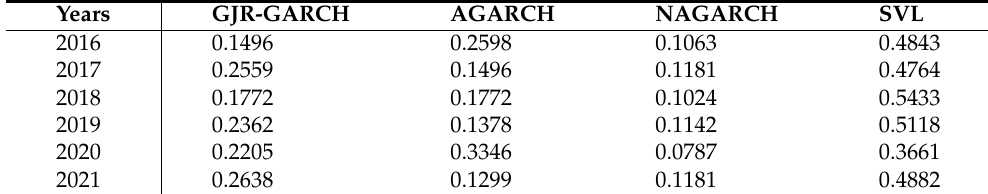
Table 4. Model performance comparison, based on in-sample volatility estimates. Years GJR-GARCH AGARCH NAGARCH SVL 2016 0.1496 0.2598 0.1063